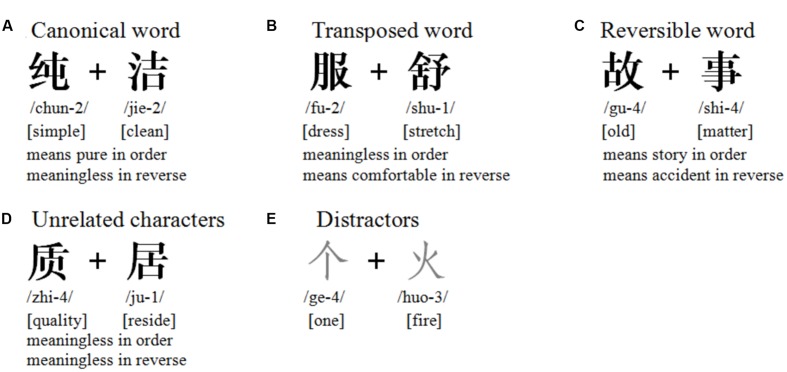
Examples of the four categories of experimental stimuli pairs and distractors.
(A) Canonical word, (B) transposed word, (C) reversible word, (D) unrelated characters, (E) distractors. The pronunciation and word meanings of each constituent morpheme of the compound words are listed below the characters; the number following pinyin denotes the tone.